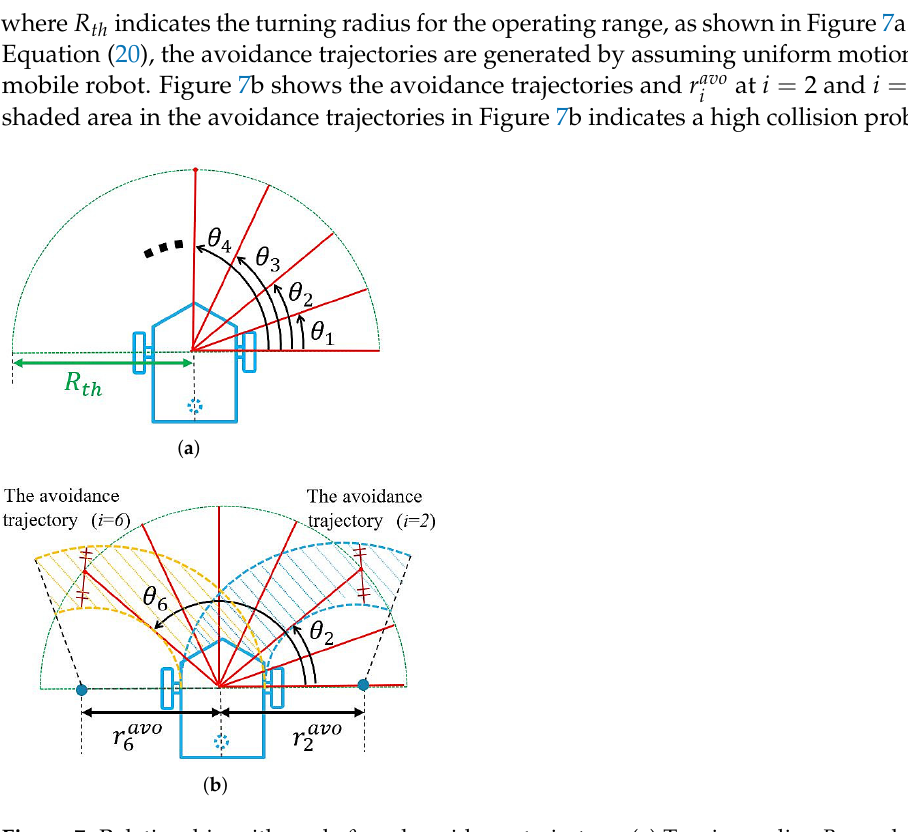
Figure 7. Relationship with angle θ i and avoidance trajectory. ( a ) Turning radius R th and angle θ i . ( b ) Avoidance trajectory and r avo i